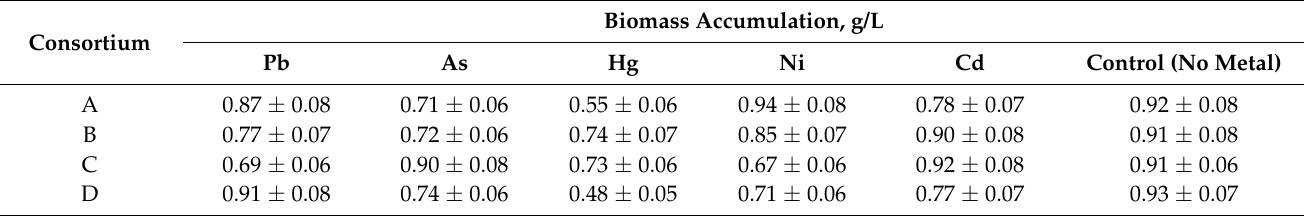
Table 7. Accumulation of biomass by consortiums in an environment with individual heavy metal.